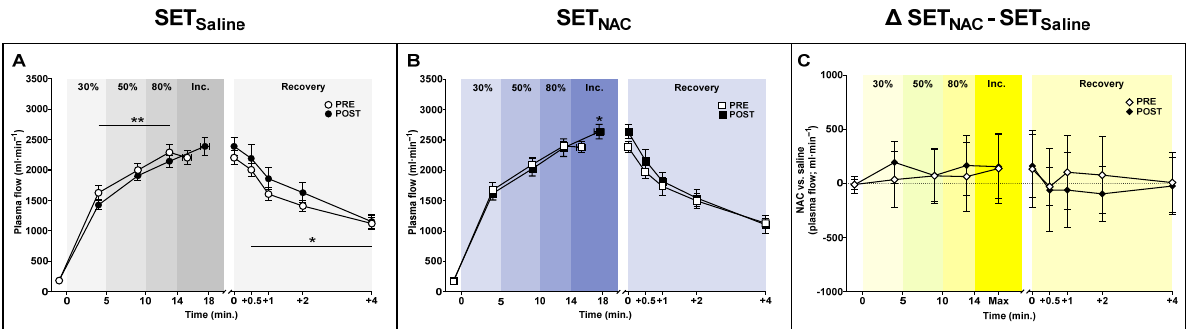
Figure 3. Effect of speed endurance training (SET) on femoral arterial plasma flow without and with N -acetylcysteine infusion. Femoral arterial plasma flow before, during, and after knee-extensor exercise without (( A ), SET Saline , n = 10), and with N -acetylcysteine (( B ), SET NAC , n = 9) infusion as well as difference ( ∆ ) between SET NAC and SET Saline (( C ), n = 9) before (Pre) and after (Post) SET. ** Post different from Pre ( p < 0.05). * Post different from Pre ( p < 0.05). Data are presented as mean ± SEM (SET Saline and SET NAC ) or mean ± 95% CI ( ∆ SET NAC − SET Saline